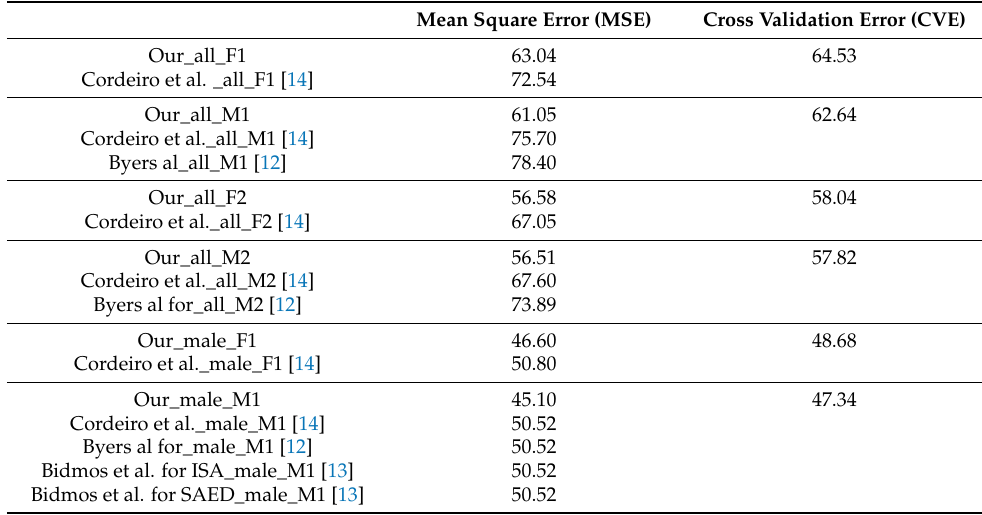
(CVE) for interval validation of total sample in Korean